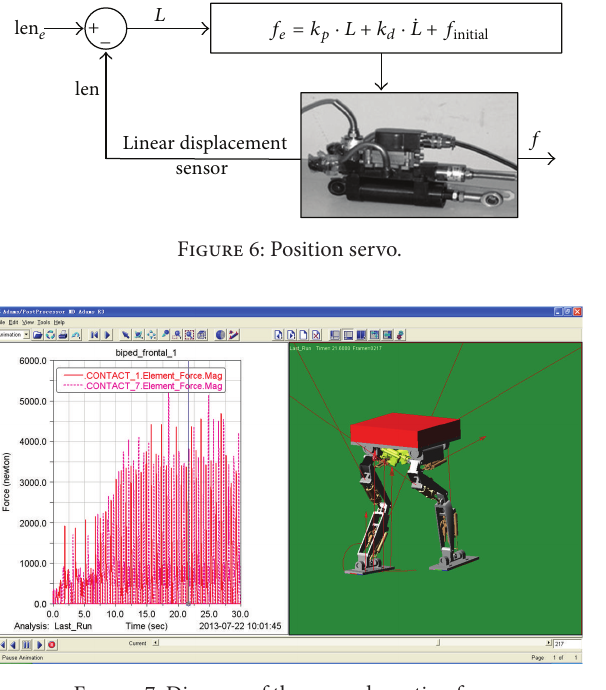
Figure 8: Structure of balance controller on uneven